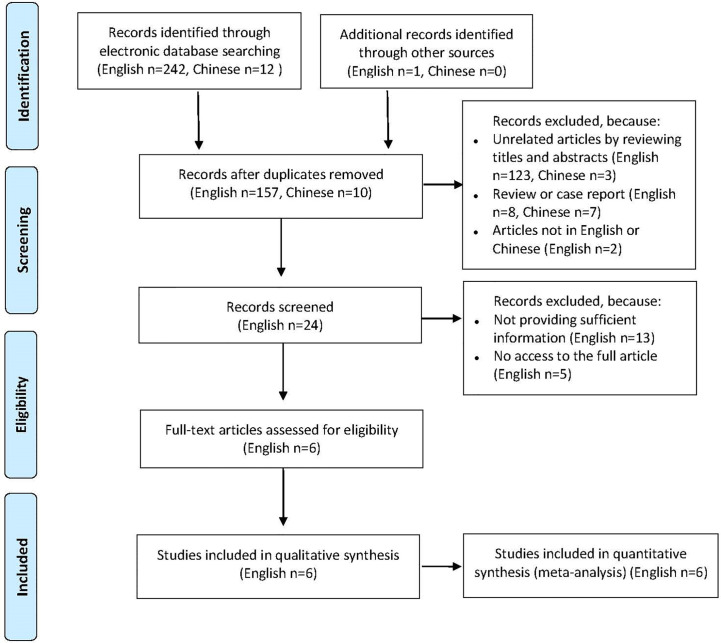
Flowchart of study selection process.